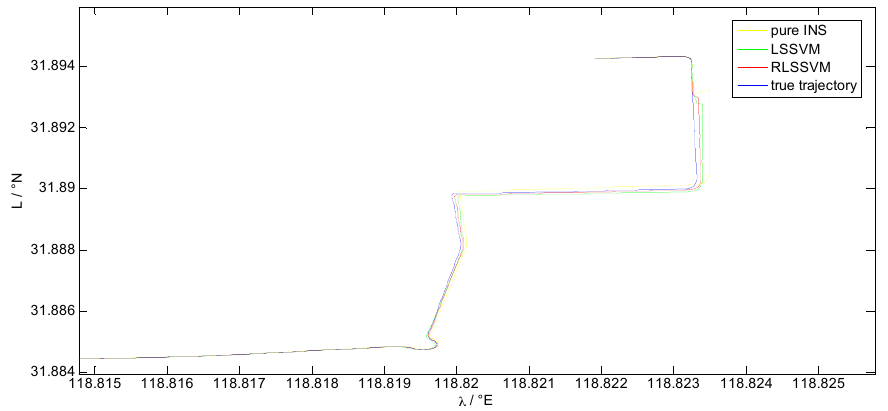
Figure 9. Positioning results of different algorithms.